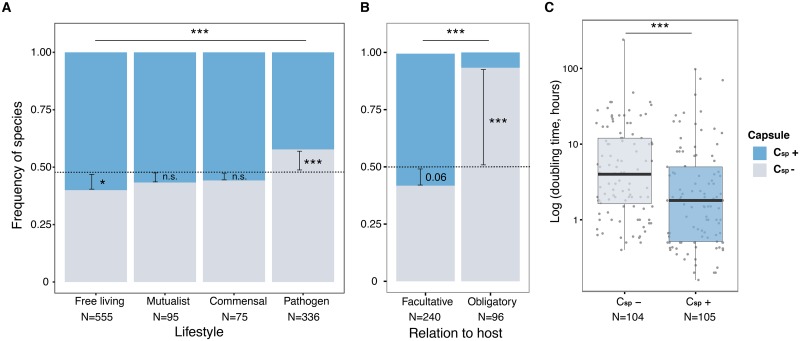
Association between the presence of capsules and lifestyle traits.Frequency of bacterial species with and without detectable capsule system in function of their lifestyle (A) and level of host-association (B). Two different statistical assays were performed. Stars inside bars represent the result of two-tailed binomial tests to measure the difference between the observed over the expected events, indicated by the dashed line corresponding to the database bias. The P-values shown on top of the bars represent the result of the test of dependence between the two traits corrected by the phylogeny as calculated by the fitPagel function included in the phytools package for R. C. Minimum doubling time across Csp+ and Csp- bacteria. Statistics correspond to the test of a significant difference between the two groups (Wilcoxon rank sum test). ** P < 0.01 *** P < 0.001. It was controlled for phylogeny using the compar.gee function. The controls for phylogeny were done (in panels A, B, and C) using 100 trees obtained by bootstrap experiments to account for uncertainty in the phylogenetic reconstruction. The distributions of the corresponding 100 P-values are provided in S5 Fig. (see Methods).